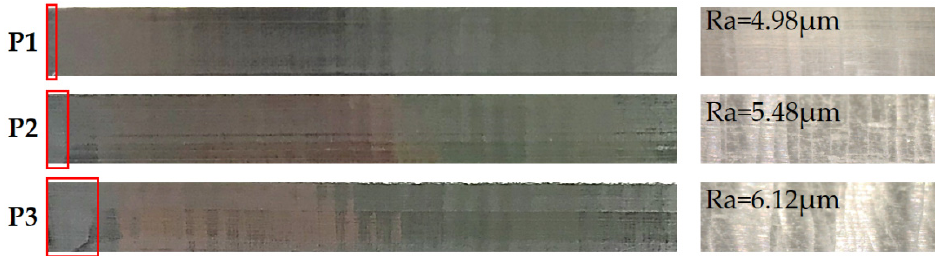
Figure 15. Milled surfaces of P1–P3.